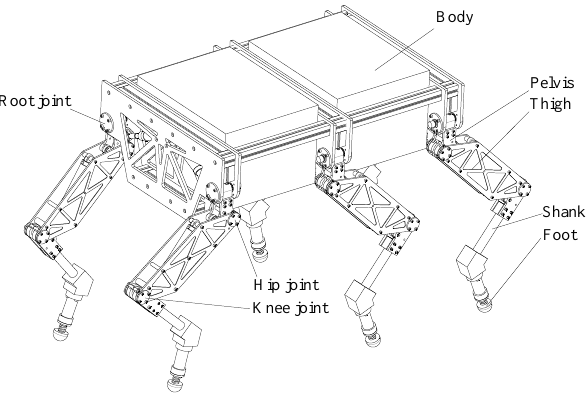
Figure 1. Hydraulic hexapod robot.